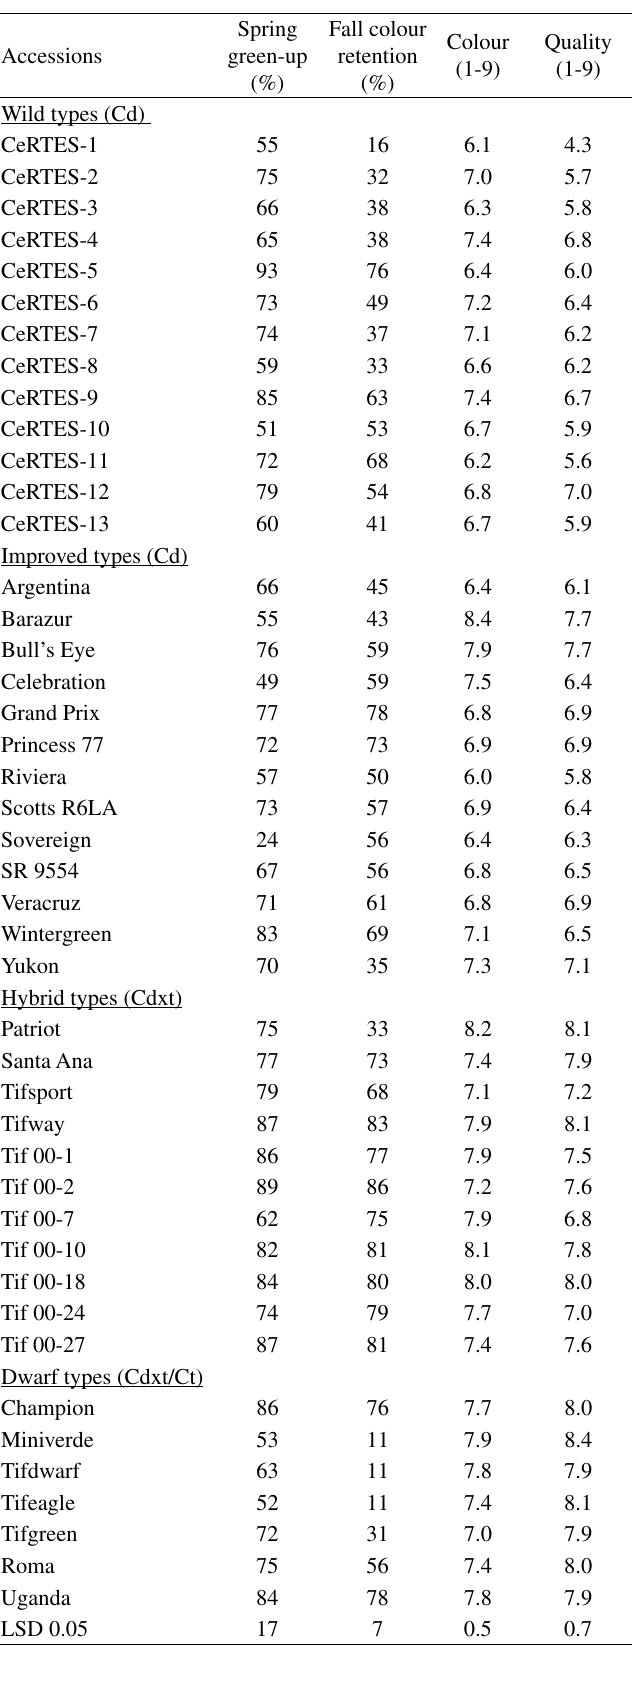
Table 4 - Bermudagrass [ Cynodon (L.) Rich.] accessions. Spring green- up (April 14 2011) and fall colour retention (percentage of green colour) (17 December 2011). Accession effect averaged across locations. Colour (visual estimation based on a 1-9 scale) and quality (visual estimation based on a 1-9 scale) refer only to the Pisa location (mean values May-October